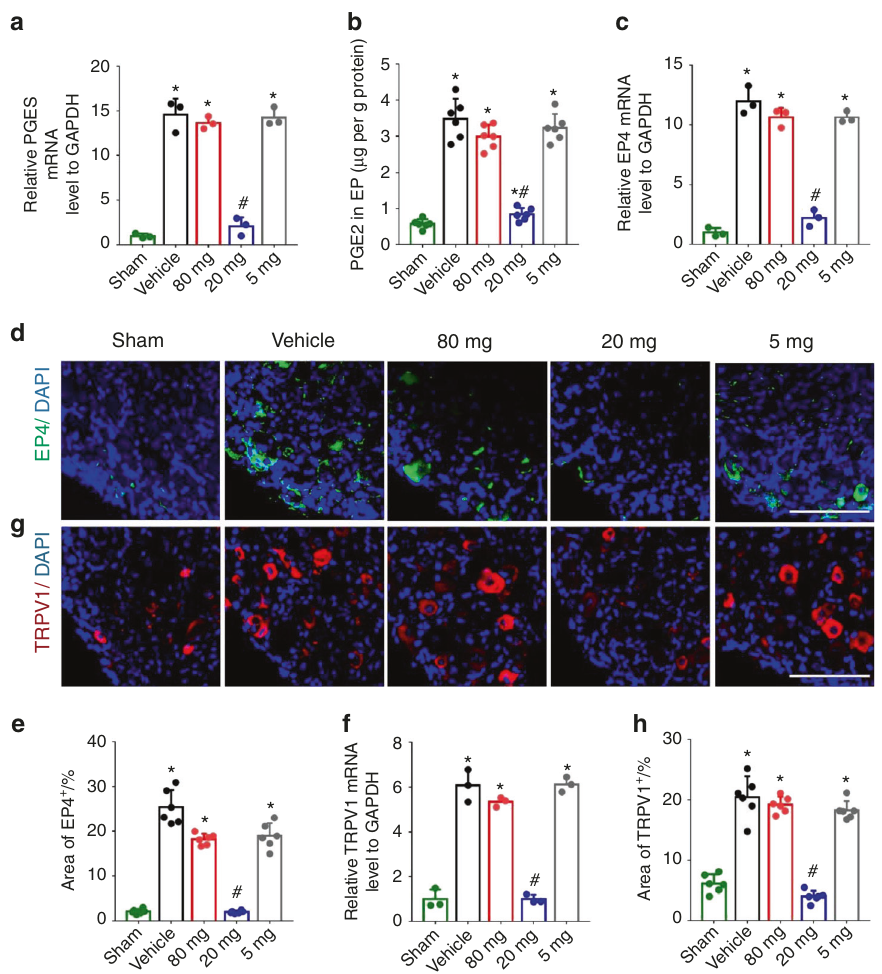
Fig. 9 EP4 and TRPV1 expression in dorsal root ganglion (DRG) neurons was reduced by low-dose celecoxib. a Quantitative analysis of PGES mRNA expression in lumbar endplates at 4 weeks after the discontinuation of celecoxib or vehicle treatment. b ELISAs of PGE2 concentration in lumbar endplates at 4 weeks after the discontinuation of celecoxib or vehicle treatment. c Quantitative analysis of EP4 mRNA expression in the L2 DRGs at 4 weeks after the discontinuation of celecoxib or vehicle treatment. d Representative images of immunostaining of EP4 (green) and DAPI (blue) in the L2 DRG at 4 weeks after the discontinuation of celecoxib or vehicle treatment. e Quantitative analysis of the percentage of EP4 + area in L2 DRGs. f Quantitative analysis of TRPV1 mRNA expression in the L2 DRGs at 4 weeks after the discontinuation of celecoxib or vehicle treatment. g Representative images of immunostaining of TRPV1 (red) and DAPI (blue) in the L2 DRG at 4 weeks after the discontinuation of celecoxib or vehicle treatment. h Quantitative analysis of the percentage of TRPV1 + area in L2 DRGs. Scale bars, 50 μ m ( d, g ). * P < 0.05 compared with the sham group and # P < 0.05 compared with the vehicle group at the corresponding time points. n = 3 per group ( a, c, f ); n = 6 per group ( b, e, h